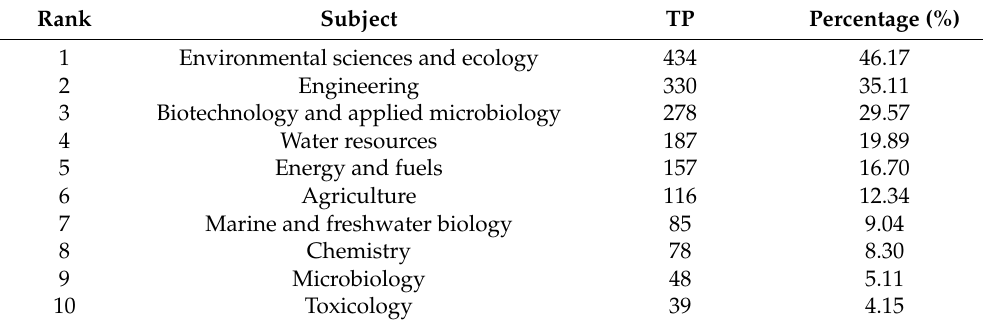
Table 1. The 10 most productive subjects during